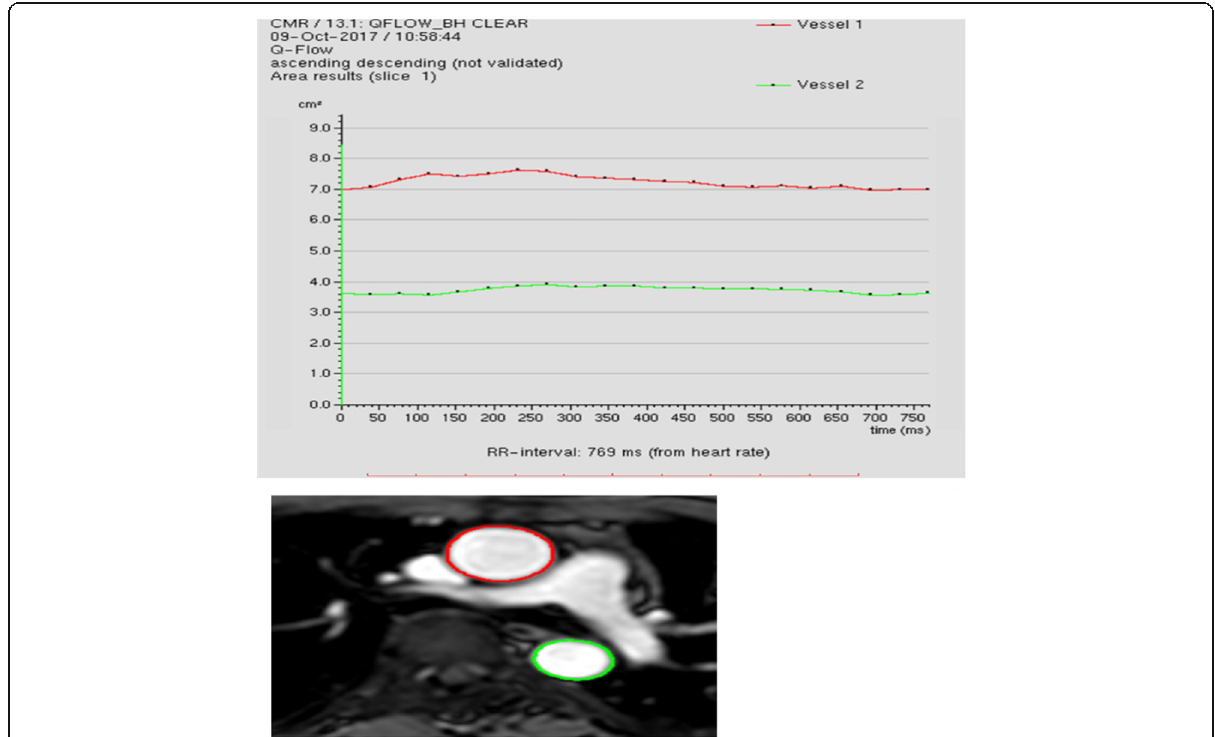
Fig. 1 Snapshot image from Philips Q flow software. TOP: chart illustrating cross-sectional area change of ascending and descending aorta at the level of pulmonary artery bifurcation during the cardiac cycle. Bottom A modulus image of Q-flow sequence of ascending and descending aorta at the level of pulmonary artery bifurcation with